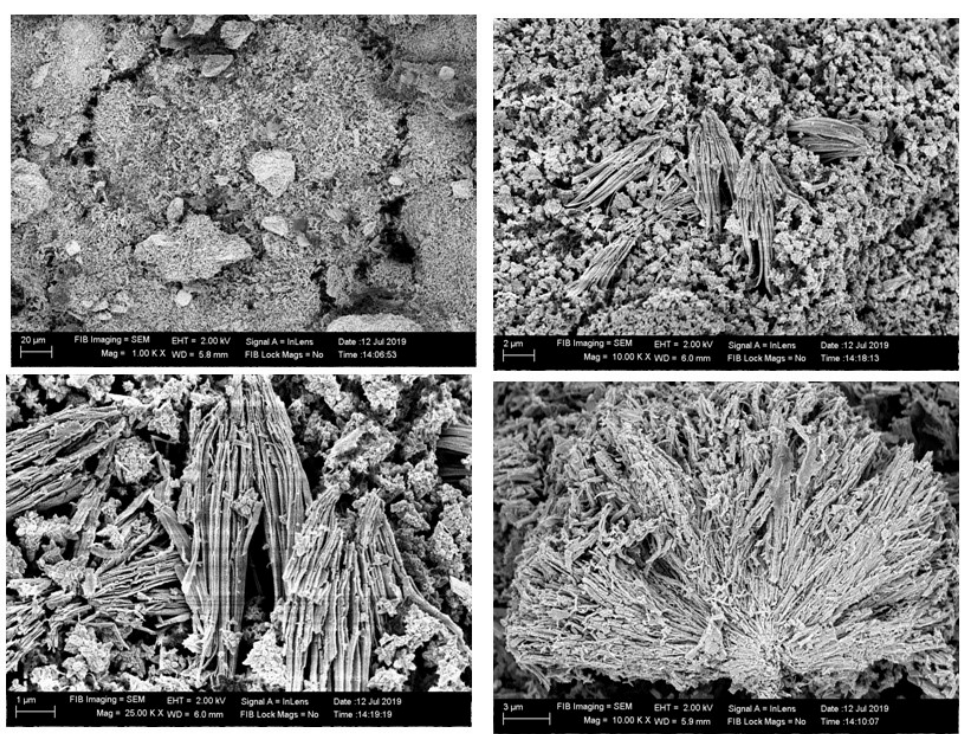
Figure 13: SEM micrographs of ZnO NPs synthesized at pH